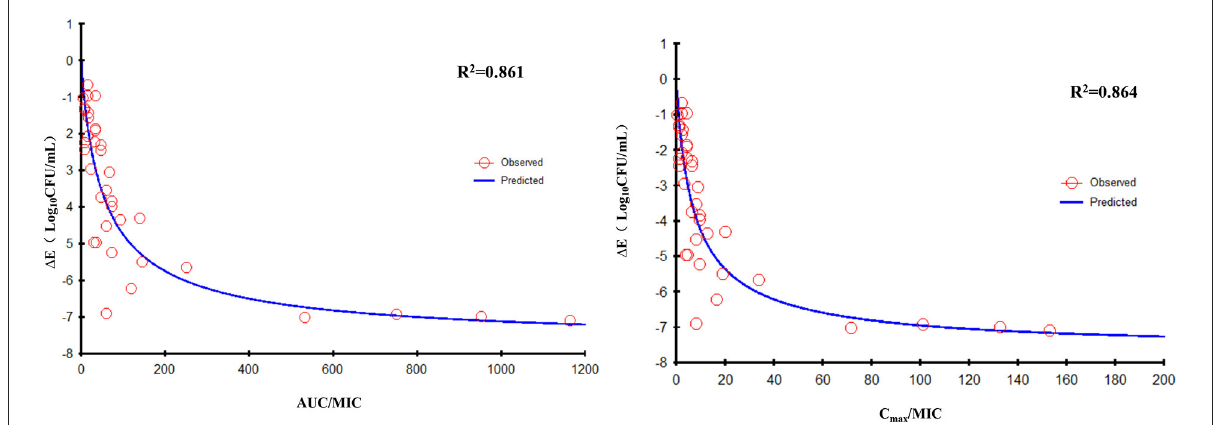
FIGURE7 E max relationships for the three PK/PD parameters of florfenicol in combination with doxycycline vs. the antibacterial effect of different isolates.